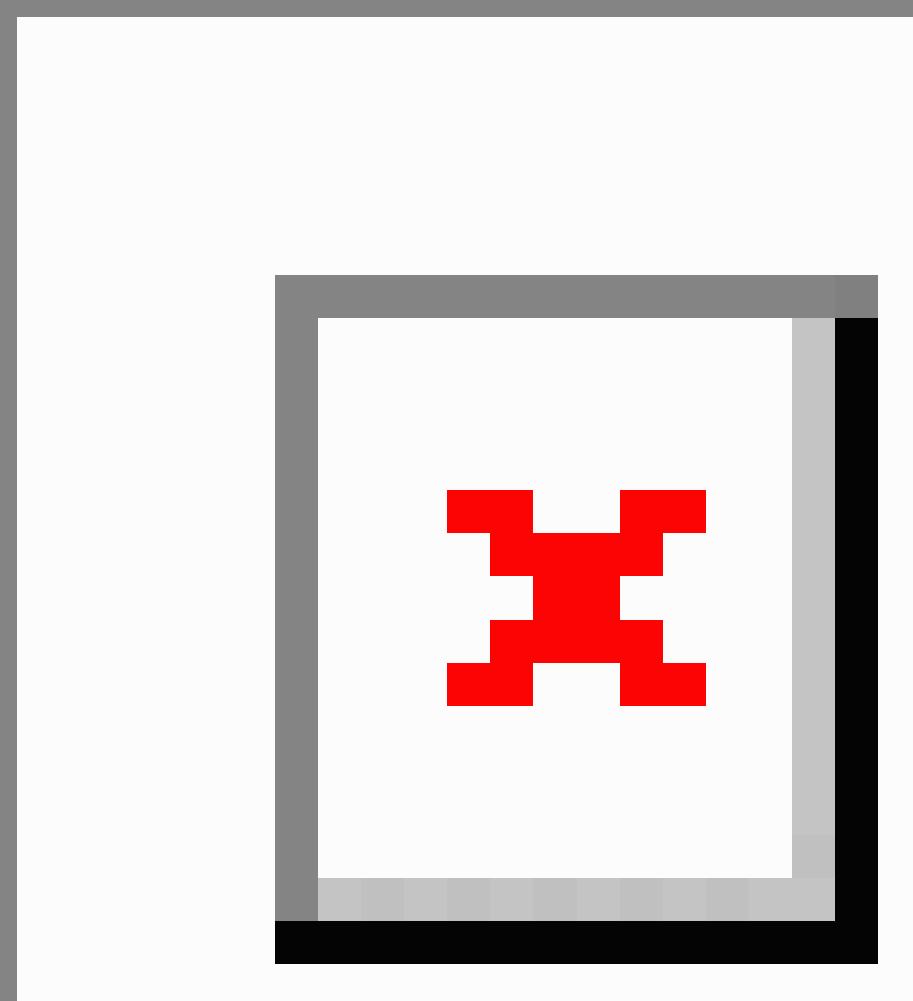
Figure 1. Walls exergame developed and evaluated as part of the